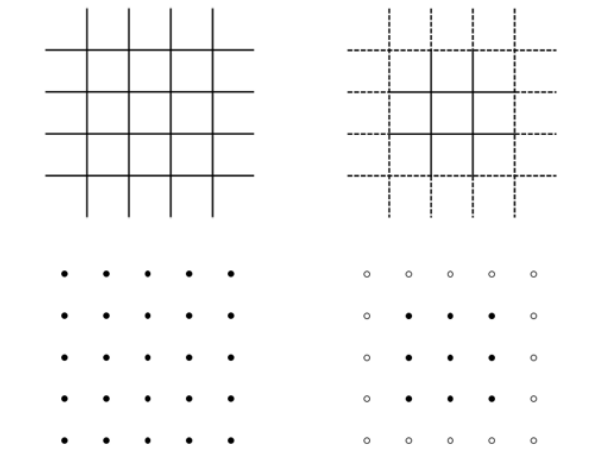
Figure 2 . Gauge (cid:12)elds in Coulomb gauge on the lattice. The (cid:12)gures correspond to square regions of size n = 3. The top two (cid:12)gures correspond to the gauge (cid:12)eld and the bottom ones to the dual scalar (cid:12)eld representation of the same algebras. Links with solid lines mean both the corresponding operators ^ A and (cid:25) belong to the algebra. Links with dashed lines mean the corresponding operator ^ A or (cid:25) does not belong to the algebra. Marked dots correspond to both the scalar (cid:12)eld operators ^ (cid:31) and _ (cid:31) . Circle dots mean the scalar (cid:12)eld operator ^ (cid:31) or _ (cid:31) does not belong to the algebra. The left panel shows the trivial center choice, while the right panel is related to the ^ A center or (cid:25) center choice (but not exactly), according to the meaning of dashed